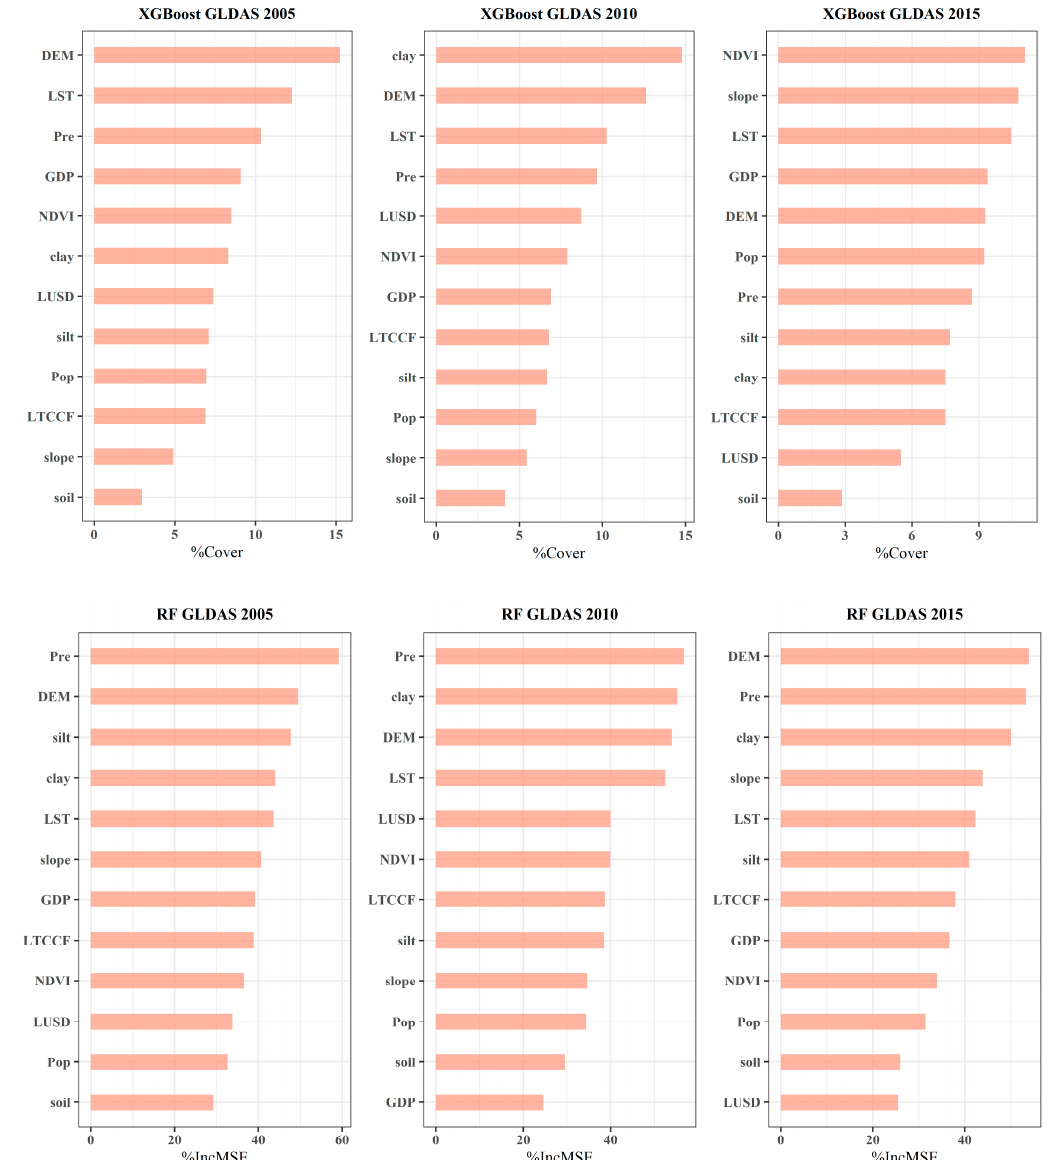
Figure 8. Plots of the variable importance measure (increase in the mean square error (%IncMSE)) for the RF-modeled GLDAS and Cover metric of the number of observation related to this feature (%Cover) for the XGBoost-modeled GLDAS for 2005, 2010 and 2015.